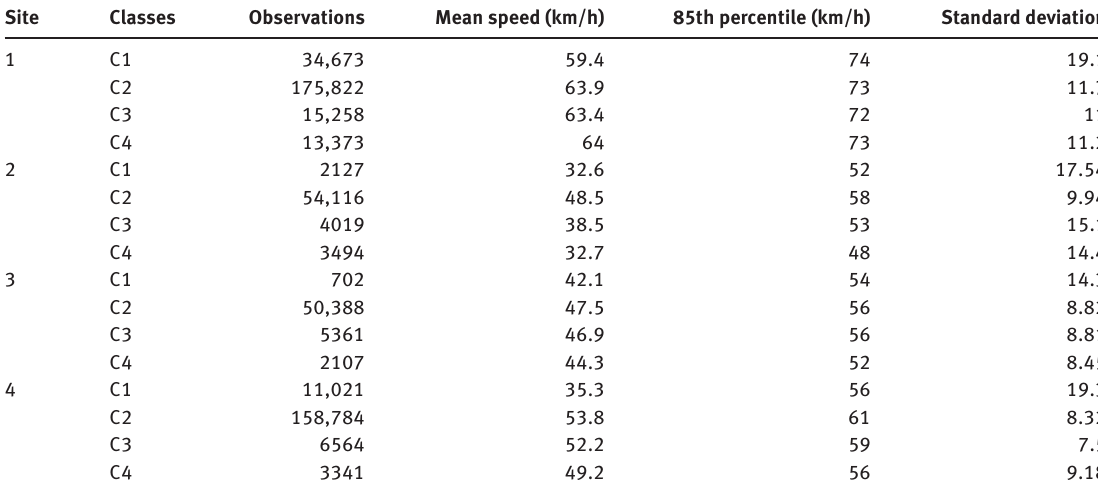
Table 1: Data Description, Number of Observations in the Original Data Set, Mean Speed, 85th Percentile, and Standard Deviation for Each Vehicle